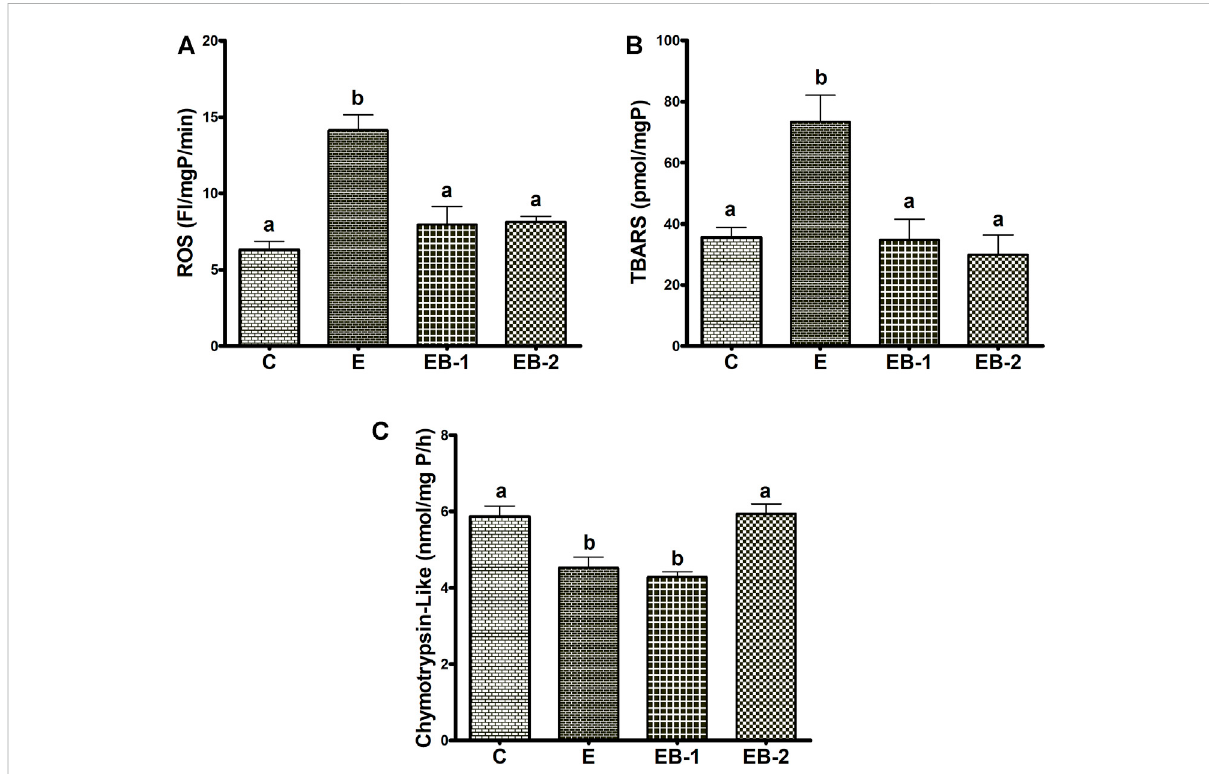
FIGURE 7 ROS, TBARS and proteasome chymotrypsin-like activity. Liver homogenates of mice gavaged with saline [C], ethanol [E], given betaine 2 h before [EB-1] or simultaneously with ethanol binges [EB-2] were quanti fi ed for (A) ROS, (B) TBARS and (C) Chymotrypsin-like proteasome activity. Data are presented as mean values ± SEM ( n = 5); values not sharing a common letter signi fi cantly differ from each other at p ≤ 0.05.